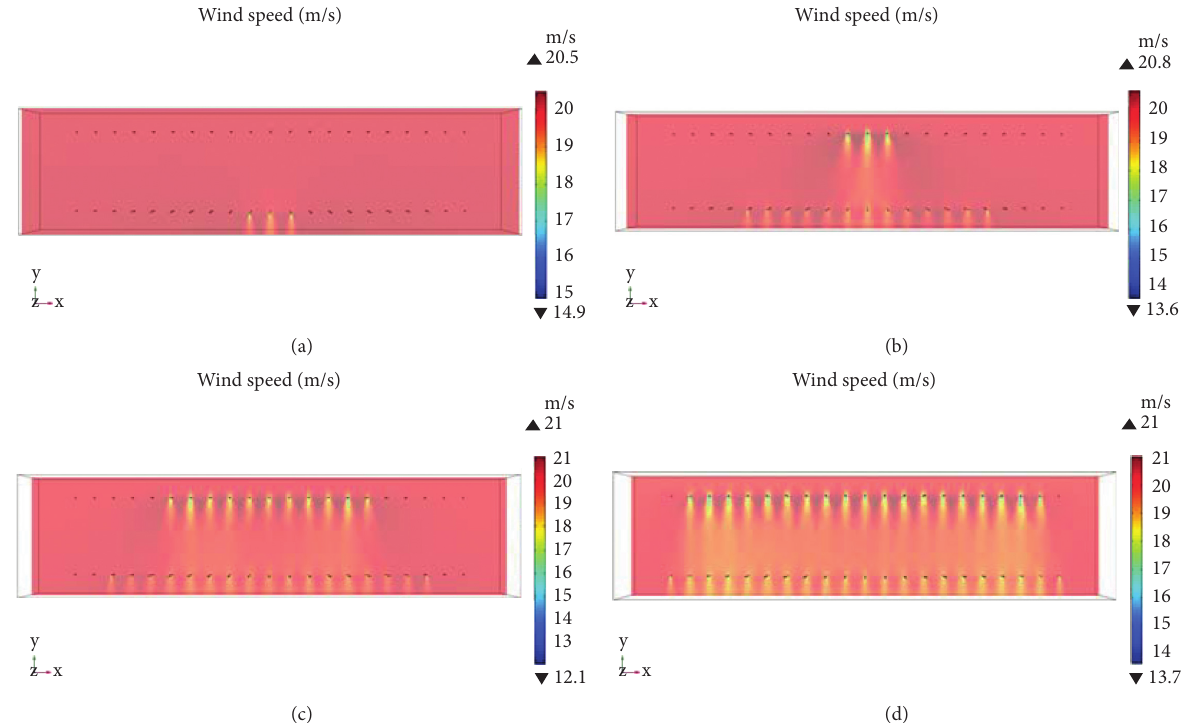
Figure 15: Influence of height for wind field (wind direction � 270 ° ). (a) 270 ° , z � 10m. (b) 270 ° , z � 5m. (c) 270 ° , z � 3 m. (d) 270 ° , z �